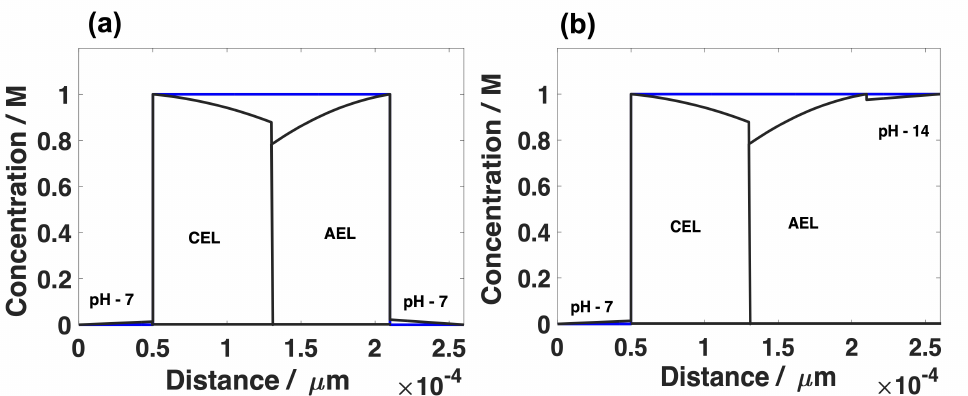
Figure 10. The concentration changes of H + and OH − ions within the CEM and AEM layer for pH 7–7 ( a ) and pH 7–14 ( b ). The concentration profile is obtained at the applied current density of 50mA · cm − 2 . The blue lines indicate the concentration at t =